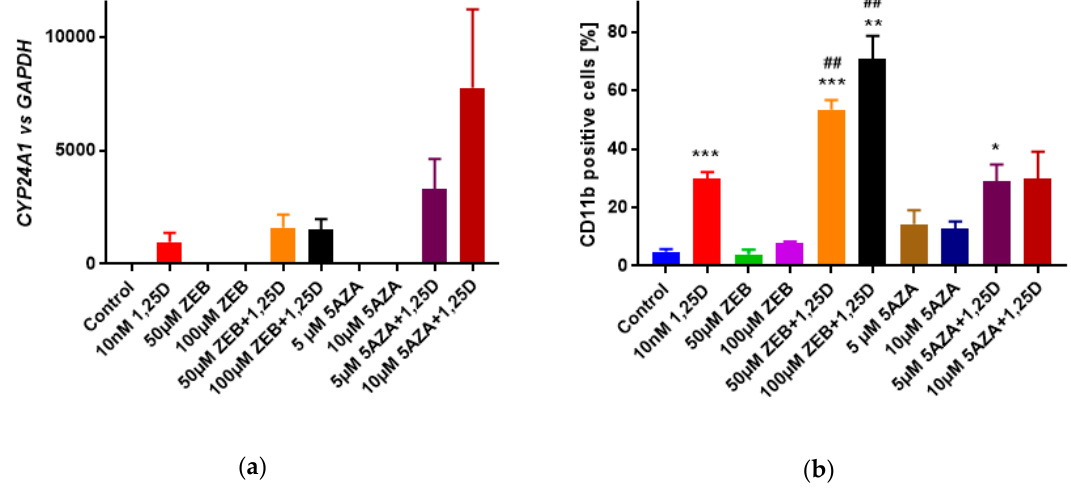
Figure 4. E ff ects of hypomethylating agents towards 1,25D-induced di ff erentiation of HL60 cells. The cells were exposed to 10 nM 1,25D ± ZEB (50 or 100 µ M) or 5AZA (5 or 10 µ M) for 96 h. ( a ) Then the expression of CYP24A1 relative to GAPDH mRNA levels was measured in three experiments. The bar charts show mean values ( ± SEM) of relative quantity. ( b ) The levels of the CD11b cell surface marker were tested in flow cytometry. The bar charts show mean values ( ± SEM) of percentages of positive cells obtained in three experiments. Values that di ff er significantly from those obtained for control cells are marked with asterisks (* - 0.05, ** - 0.01, *** - 0.001) while the values that di ff er significantly from those obtained for cells exposed to 1,25D are marked by hash tags (## ‐ 0,001).